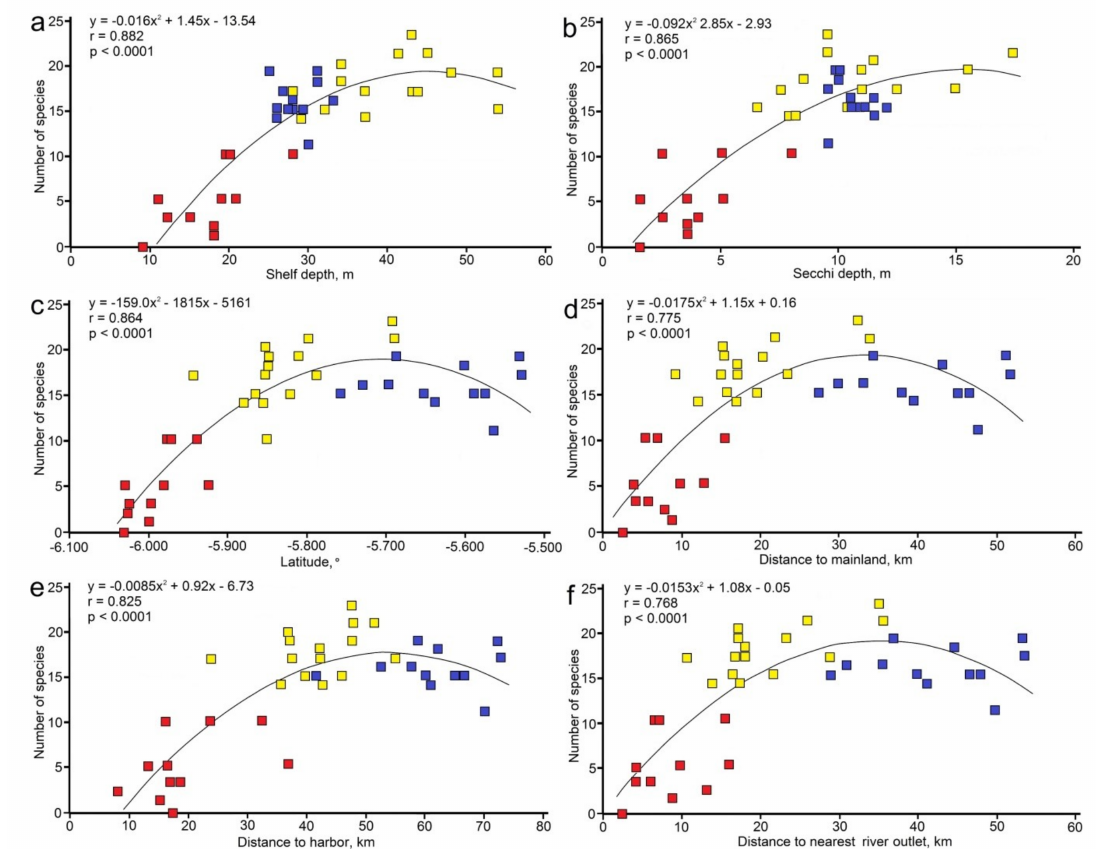
Figure 3. Significant relations (quadratic model) between mushroom coral diversity and abiotic parameters off Jakarta (2–30 m depth range): ( a ) shelf depth; ( b ) secchi depth; ( c ) latitude; ( d ) distance from mainland; ( e ) distance from harbor; ( f ) distance to nearest river outlet. Color codes correspond with those of zones in Figure 1: Zone 1 (red), Zone 2 (yellow), Zone 3